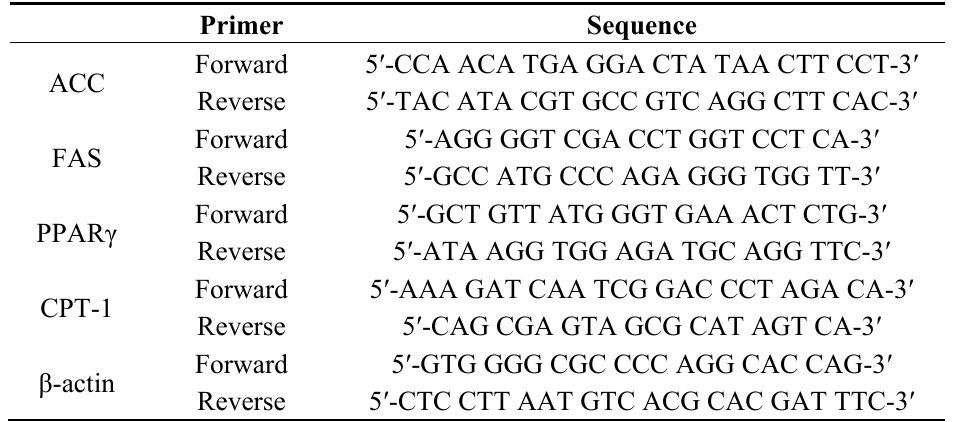
Table 1. Sequences of primers for mRNA gene analysis in liver.